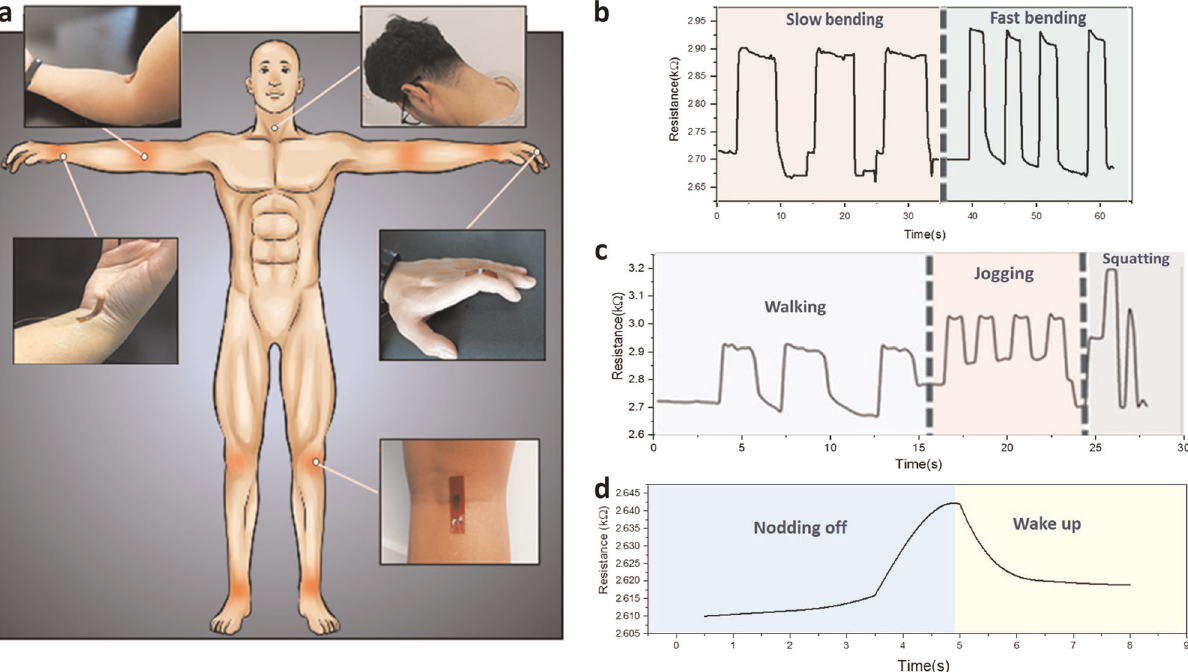
Fig. 13 a Schematic of wearable LIG bending sensors attached to different positions of a human body to monitor joint-bending-related motions. b Monitoring the response of fi nger bending c Knee-related motion monitoring: walking, jogging, and squatting. d Microsleep detection by monitoring head nodding and waking up